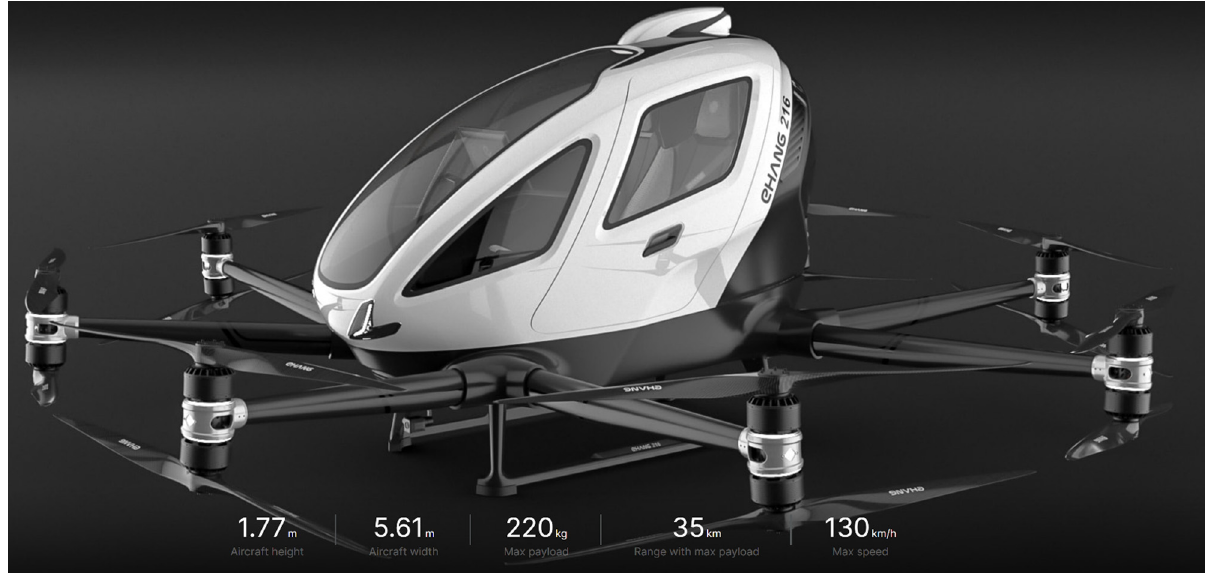
Figure 1: An illustration of the EHang 216 UAM aircraft ( image credit: EHang Holdings Limited, used with permission )